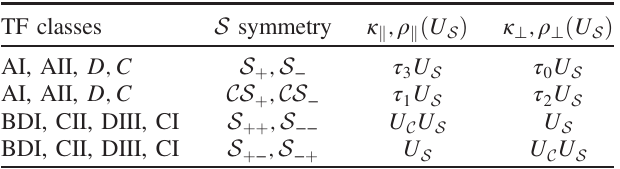
TABLE XXI. The mapped representation of the unitary order- two (anti)symmetry S under application of the dimension-raising isomorphisms κ , κ ⊥ , ρ , and ρ ⊥ for the real tenfold-way classes. k k The mapping of the Hamiltonian and the tenfold-way symmetries is given in Table XIX.